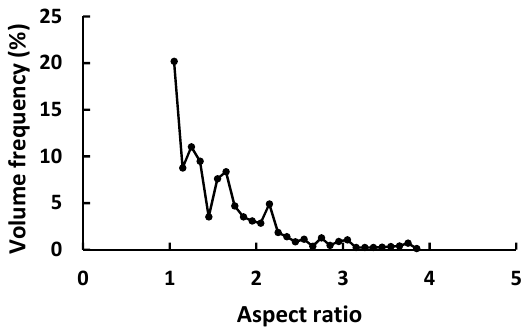
Figure 3. Volume frequency distribution of aspect ratio of cellulose particles.